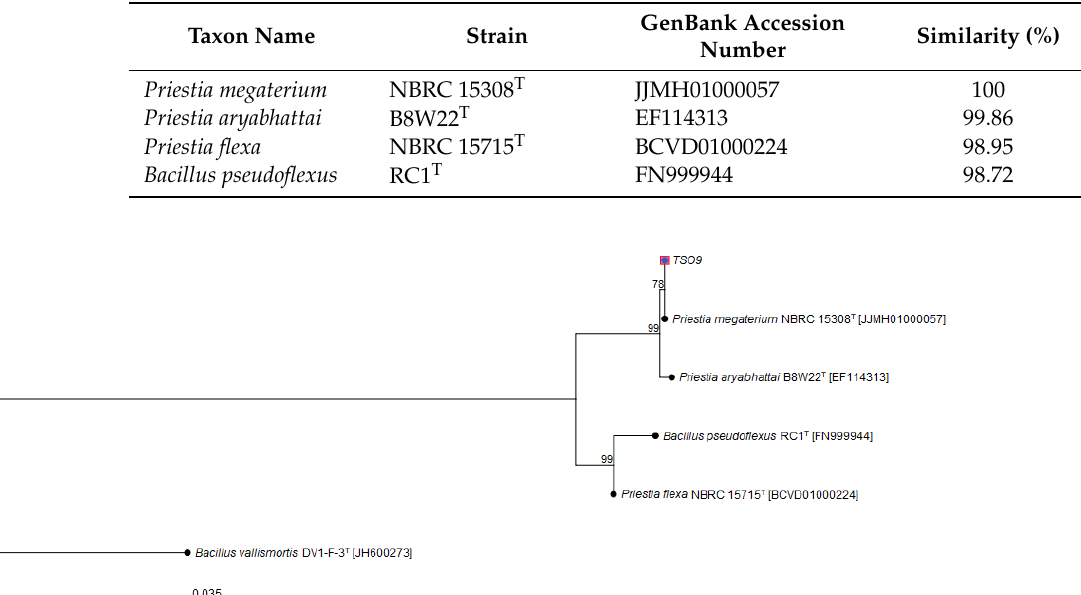
Table 2. 16S rRNA-based similarity of strain TSO9.